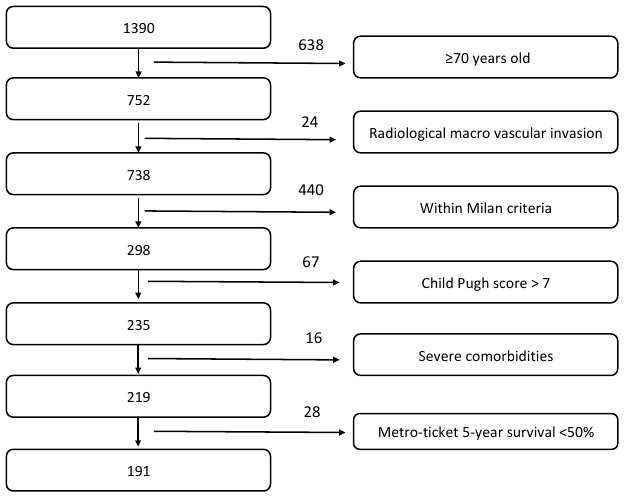
Figure 1. Enrolled population according to XXL inclusion/exclusion criteria [13].